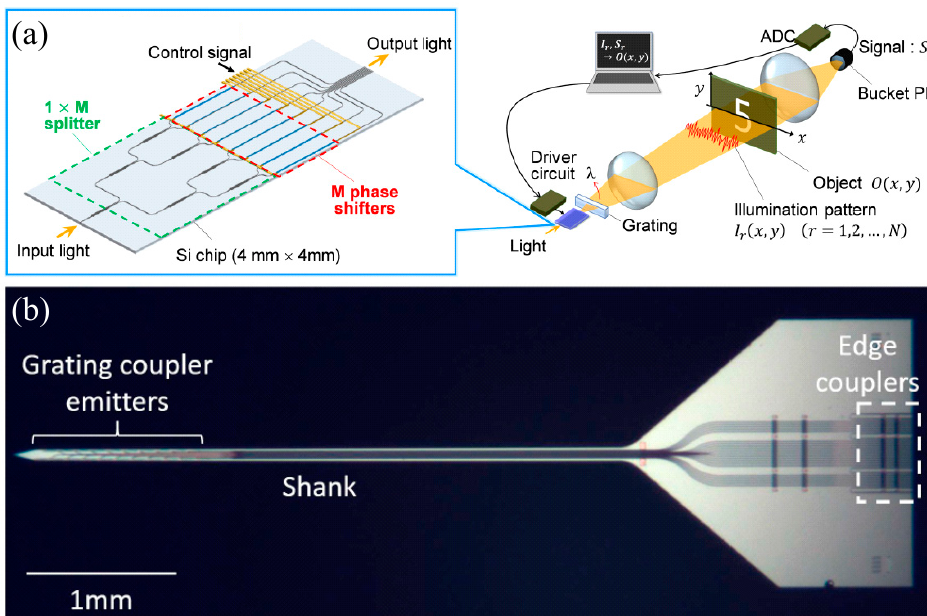
Figure 15. Applications of OPA structures. ( a ) An integrated OPA chip and the schematic of a ghost imaging system. Reprinted with permission from [54] © The Optical Society. ( b ) An implantable probe based on WGA-based OPA for optogenetic neuromodulation. Reprinted with permission from [56] © The Optical Society.